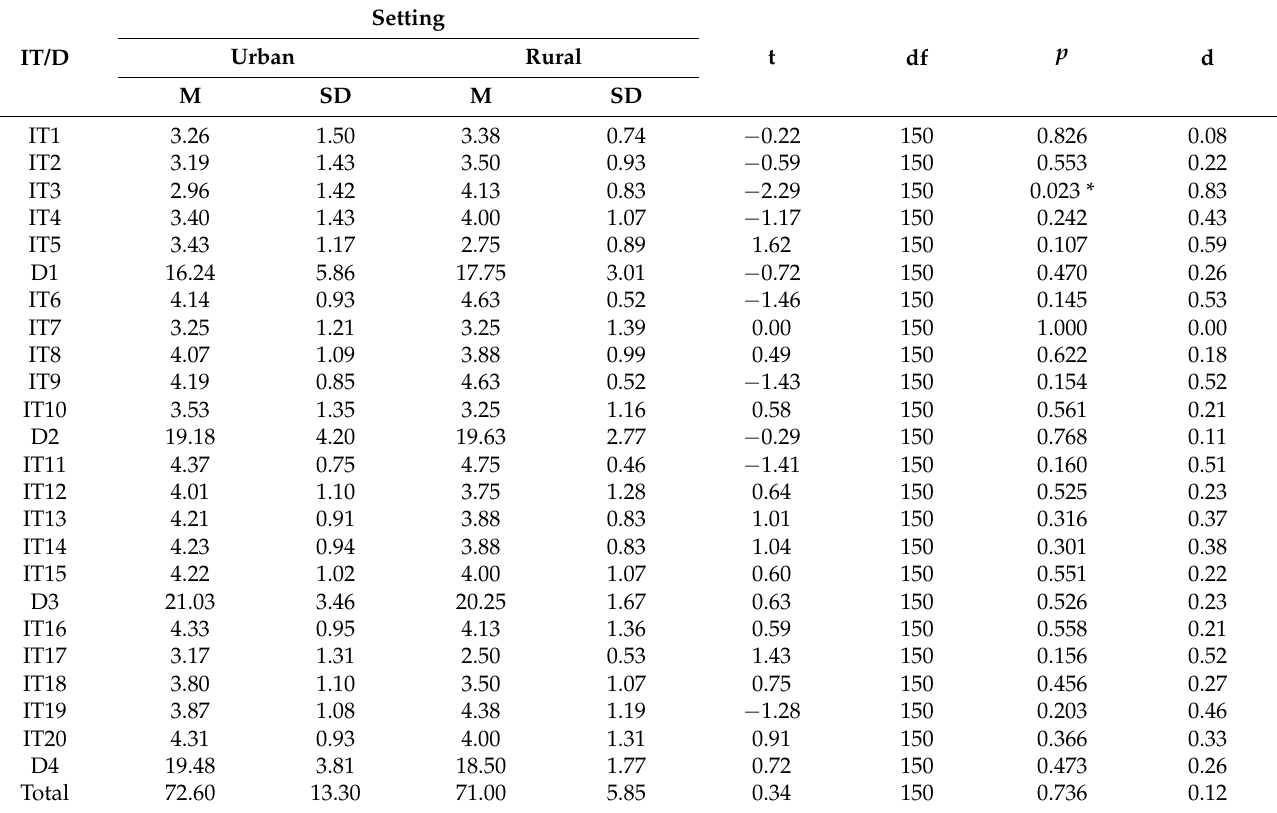
Table 6. T -test based on the variable association